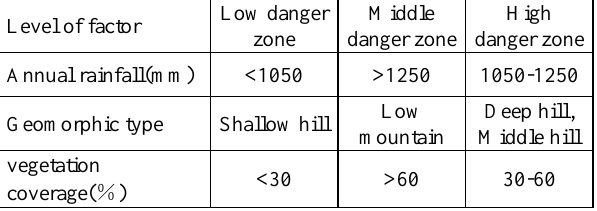
Table 5. Risk classification of potential landslides in Da Chuan District